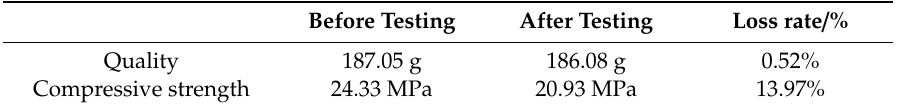
Table 6. Strength and mass loss of the M–S–H cement-solidified body with 0.8 wt % Cs before and after freeze–thaw testing.